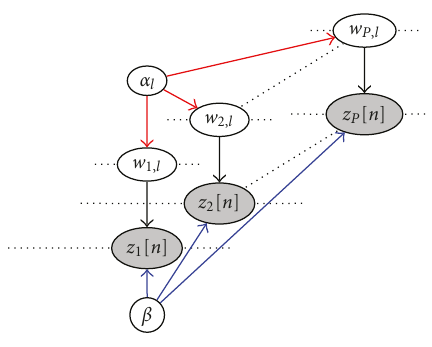
Figure 5: Usage of α l in a multiple-observation discrete-time wire- less channel model to represent P coherent channel